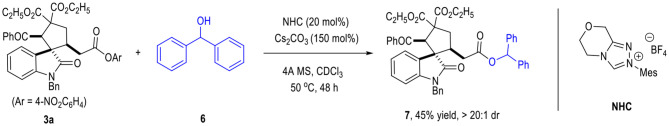
Synthetic transformations of 3a.